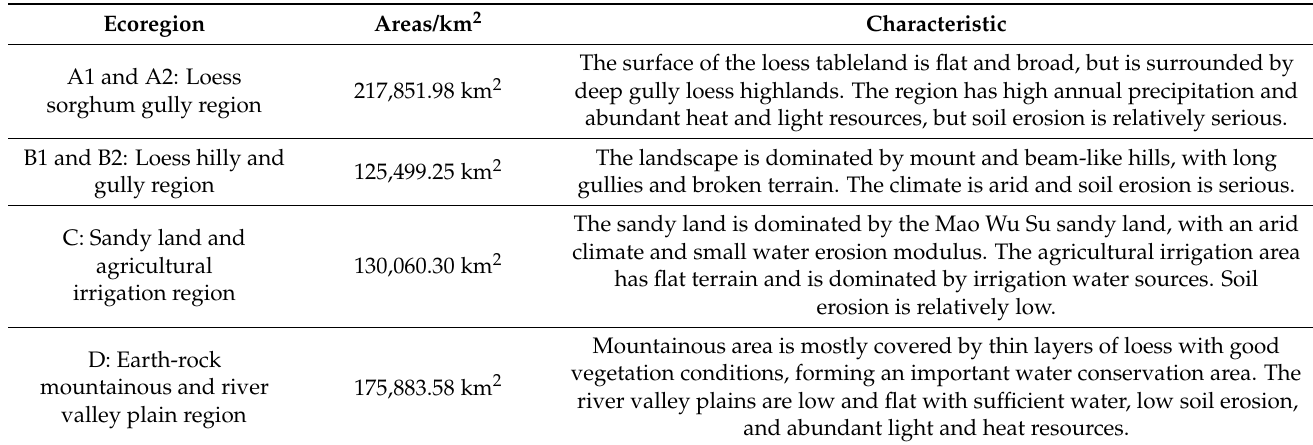
Table 1. Ecoregions of the Loess